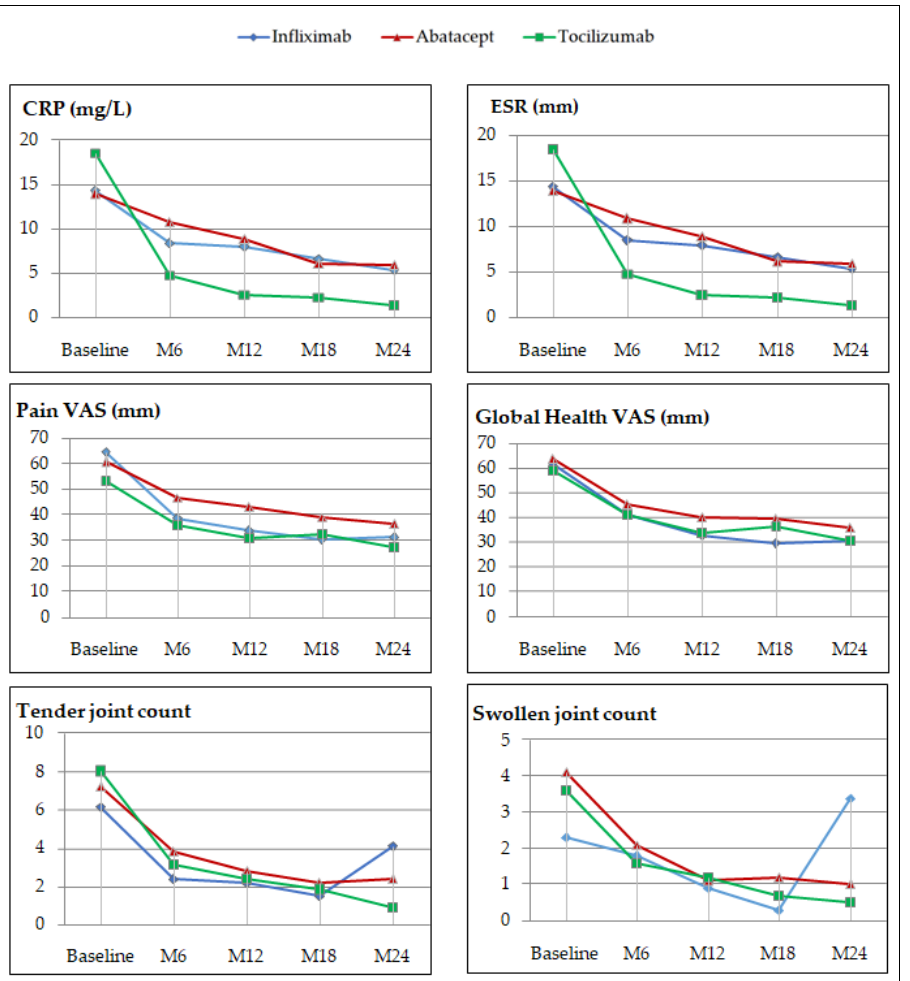
Figure 3 . Changes in CRP and ESR levels, pain and global health VAS, and numbers of tender and swollen joints during the 2-year observation CRP: C-reactive protein; ESR: erythrocyte sedimentation rate; VAS: visual analog scale.